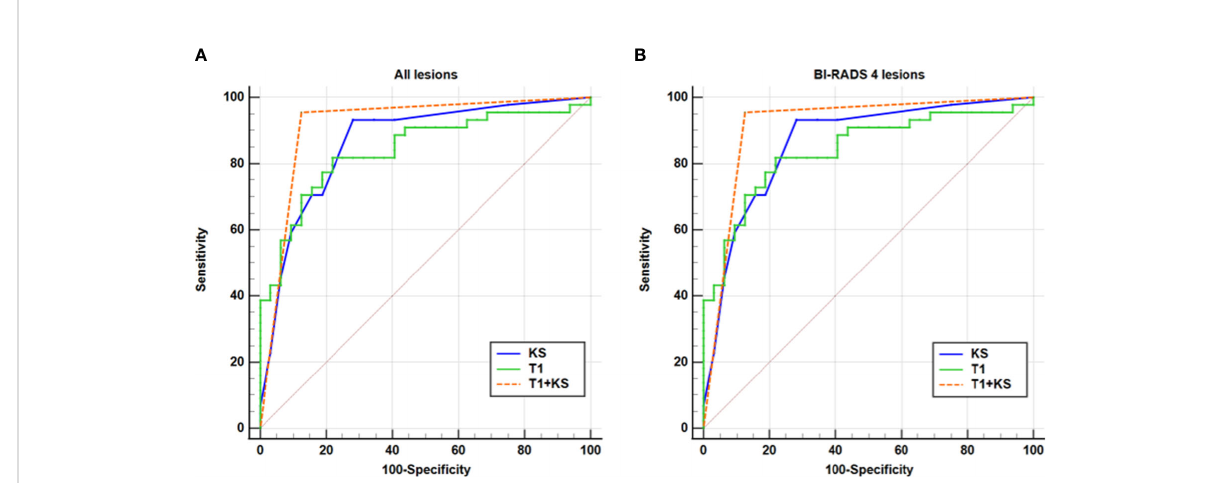
FIGURE 4 ROC analysis for T1, KS, and T1+KS. The ROC curves illustrate that a higher diagnostic value (i.e., higher sensitivity, speci fi city, and larger AUC) was reached for the combination of T1 and KS (T1+KS) in assessing all lesions (A) and BI-RADS 4 lesions (B) , compared with that using T1 and KS